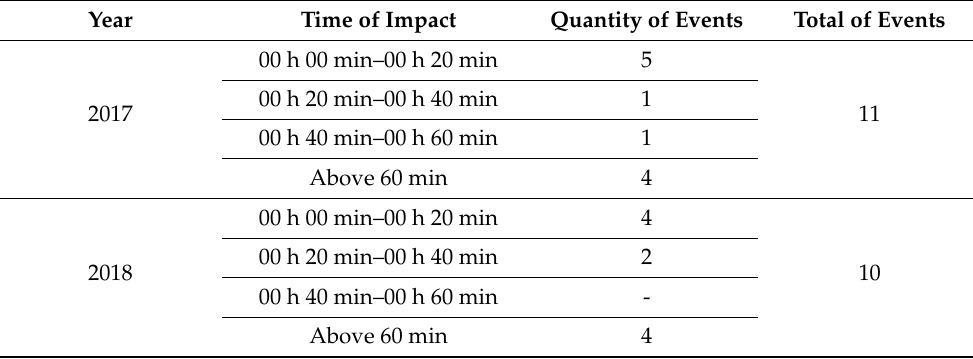
Table 2. Impact on SIN re-establishment due to auxiliary systems failures [3].